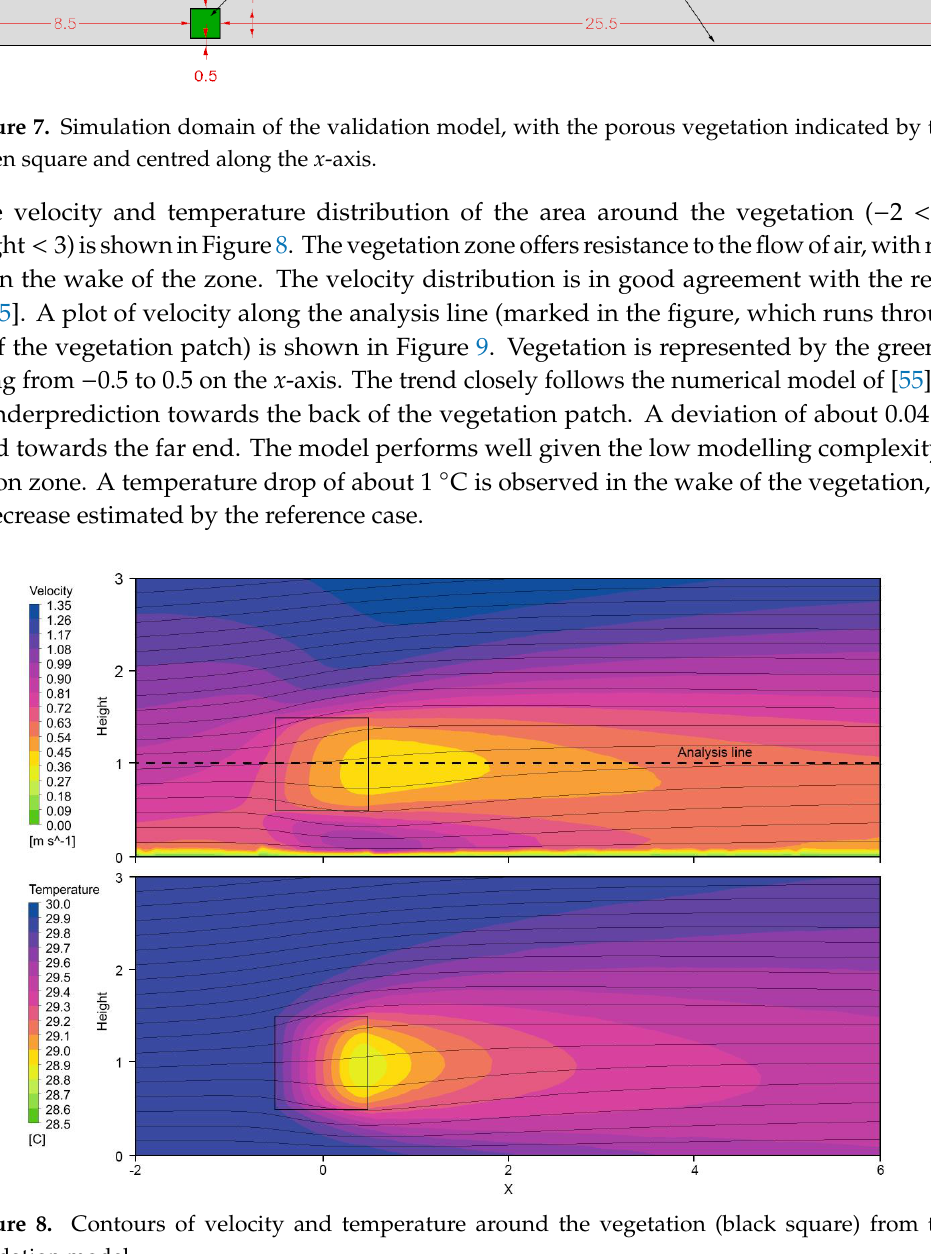
Figure 8. Contours of velocity and temperature around the vegetation (black square) from the validation model.